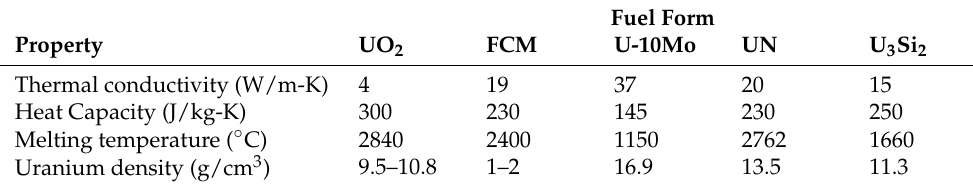
Table 1. Properties of accident tolerant fuels